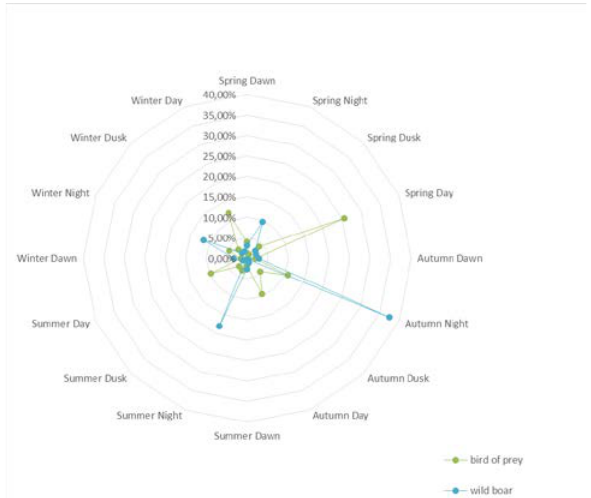
Figure 3 Spatial distribution of WVC comparing the seasons for the period 2010 - 2014 The temporal distribution (season and day time) of WVC depends strongly on the species. Figure 4 shows exemplarily the day time and seasonal distribution for bird of prey and wild boar as the species with the most significant temporal concentration of WVCs while this general pattern can also be transferred to other species.